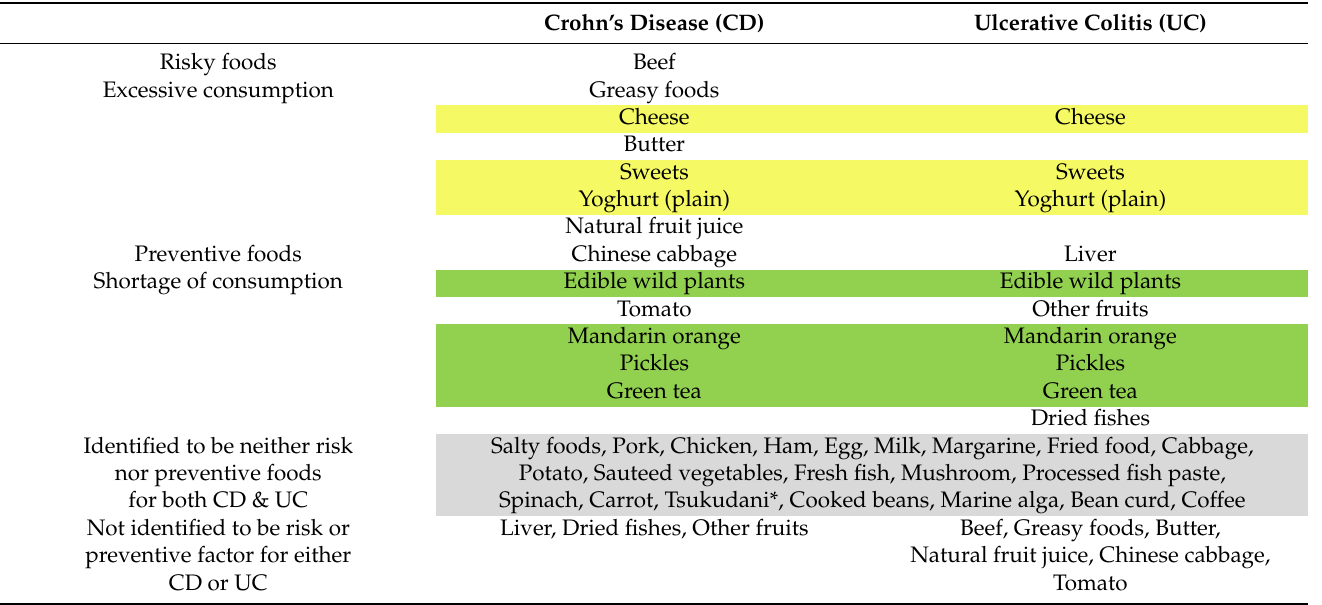
Table 3. Case-control Studies on 37 foods for IBD onset in